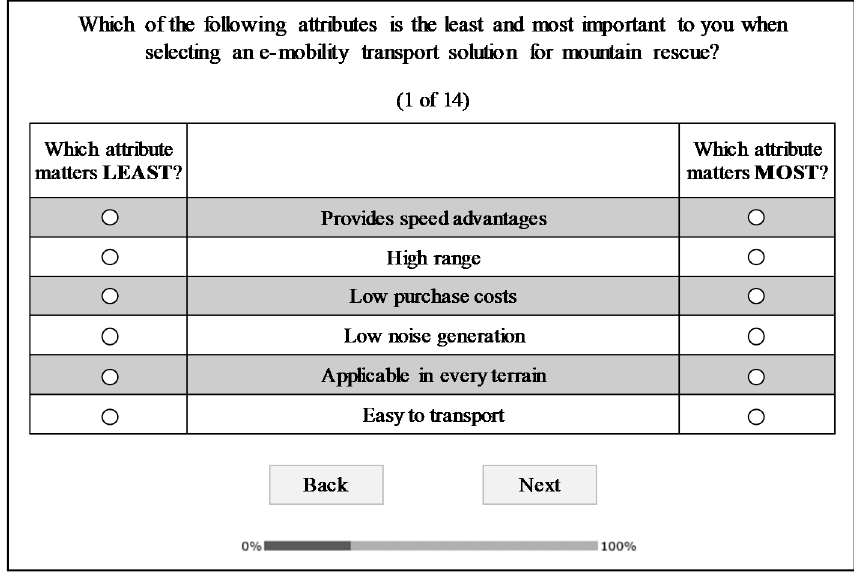
Figure 2. Example of the best–worst combination.